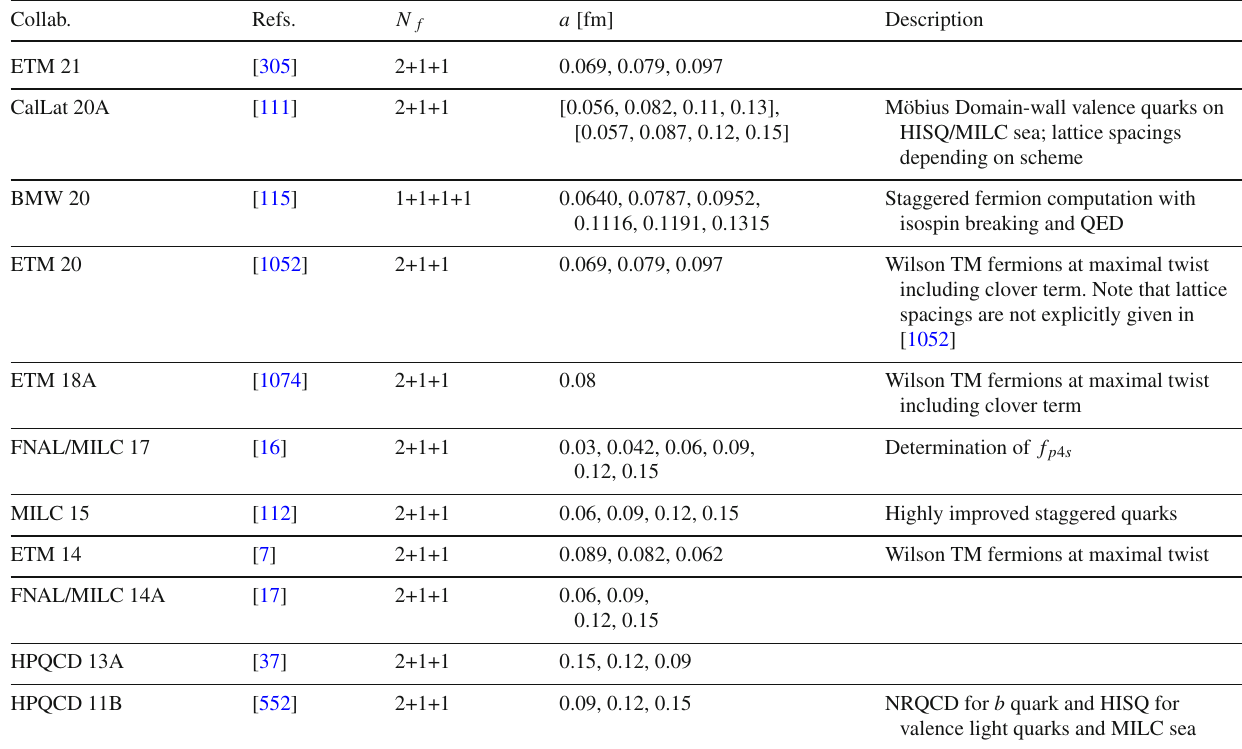
Table 197 Continuum extrapolations/estimation of lattice artifacts in scale determinations with N f = 2 + 1 + 1 quark flavours